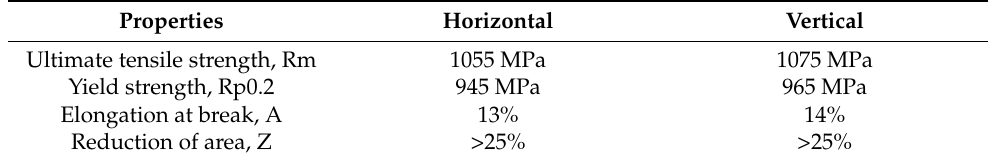
Table 2. Tensile data at room Table 1. The chemical composition of the powder (wt, %).